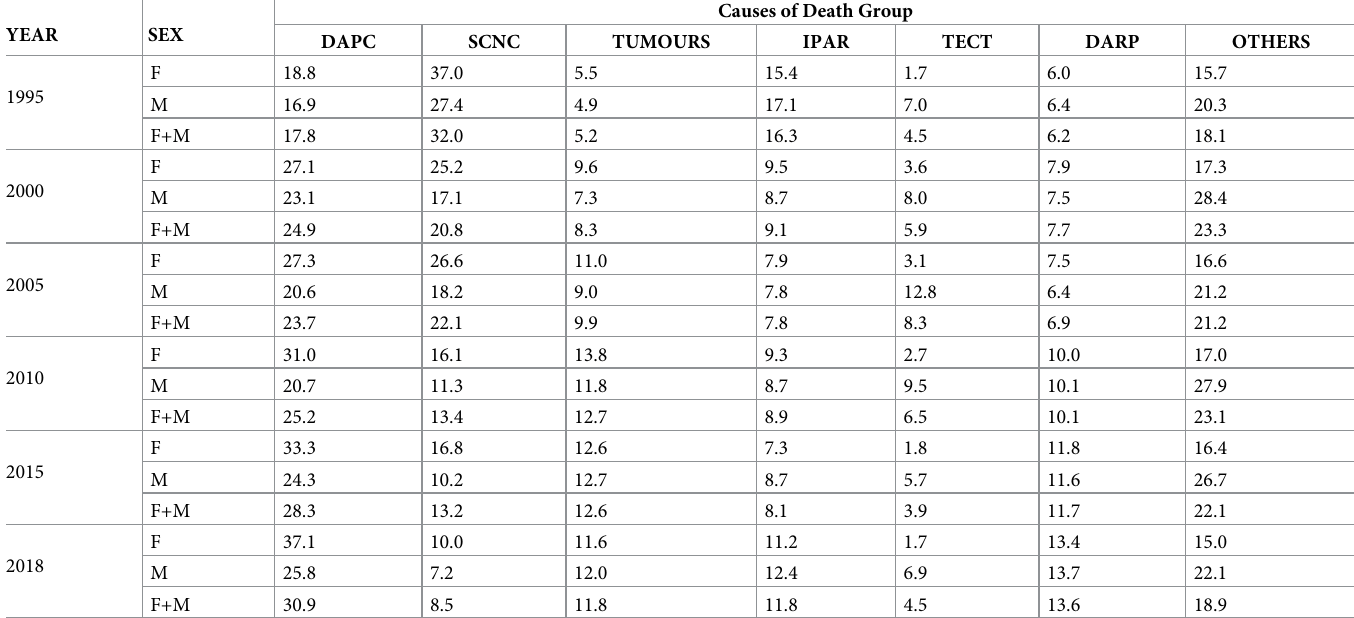
Data source: Ministry of Health of Cabo Verde.